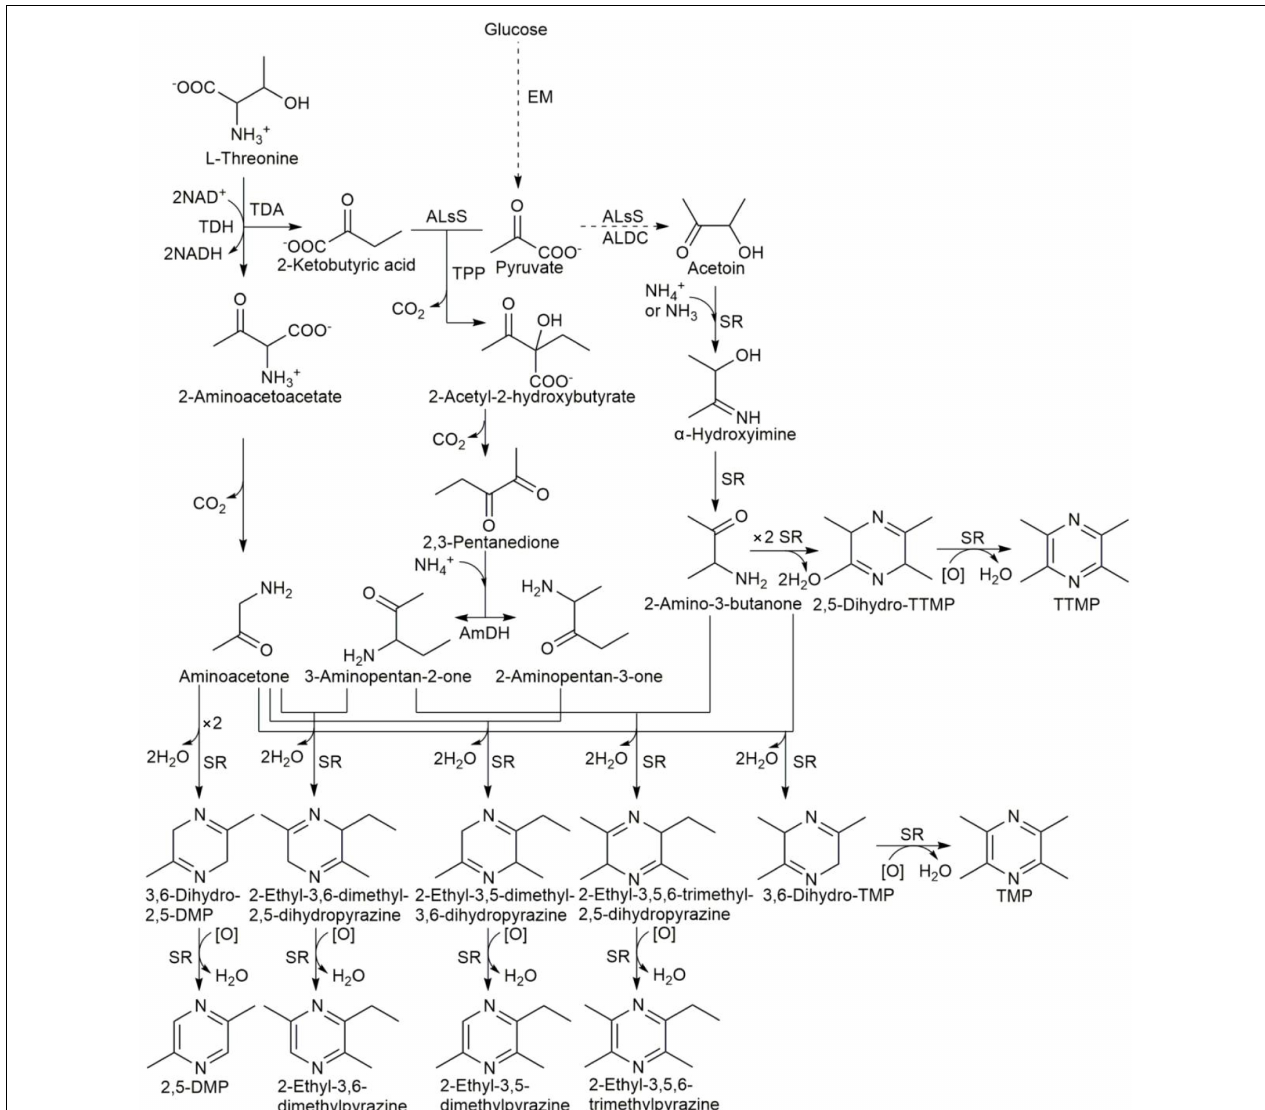
FIGURE 7 | Synthesis pathways of alkylpyrazines in B. subtilis . EM, Embden-Meyerhof pathway; ALsS, acetolactate synthase; ALDC, α -acetolactate decarboxylase; TDH, L-threonine-3-dehydrogenase; TDA, threonine deaminase; AmDH, amine dehydrogenase; SR, spontaneous reaction under standard pressure and moderate or high temperature. The pathways were proposed by Zhang et al. (46,